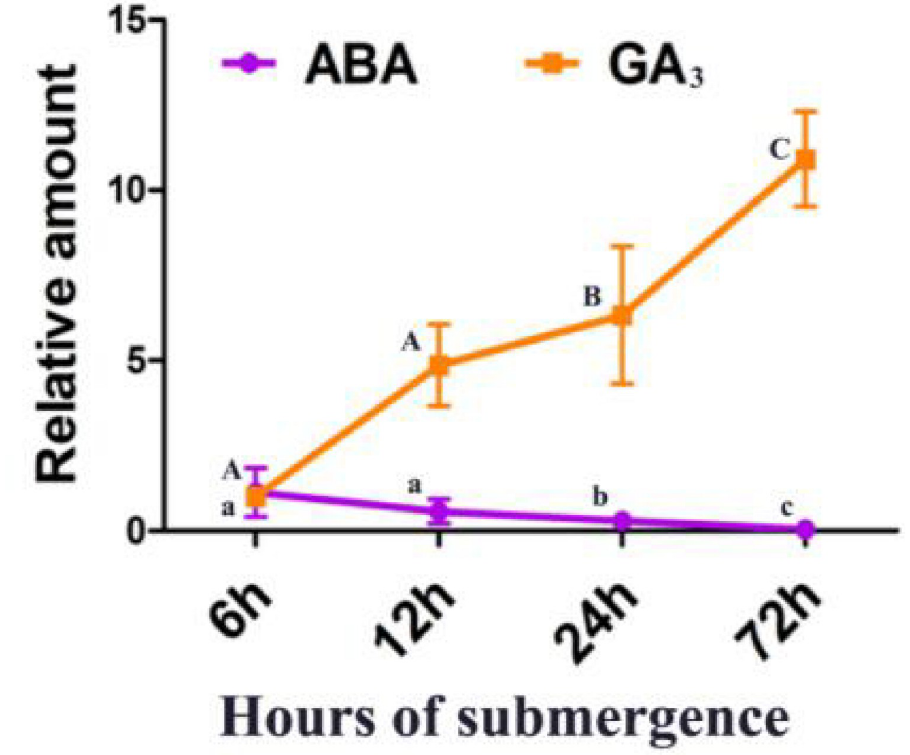
Fig 2. The flooding stress treatments increased endogenous GA 3 and decreased endogenous ABA in the F . hodginsii seedings. The tested seedings were local varieties of Fuzhou and were cultivated hydroponically for 2 weeks. The hydroponic solution was 10 g nutrient solution mixed with 1 L water. For the flooding stress treatments, the seedings were submerged in water for 6 h/12 h/24 h/72 h, the leaves were collected, and the endogenous ABA and GA 3 were determined. Three independent experiments were performed, each with three biological replicates. Data are the means of three biological repetitions ± SD, n = 9. Different capital letters (A, B, C) indicate the significance of GA 3 content at different treatment times compare to 6 h (p < 0.05), while different lowercase letters (a, b, c) indicate the significance of ABA content at different treatment times relative to 6 h (p < 0.05), Tukey-test was used for comparison between